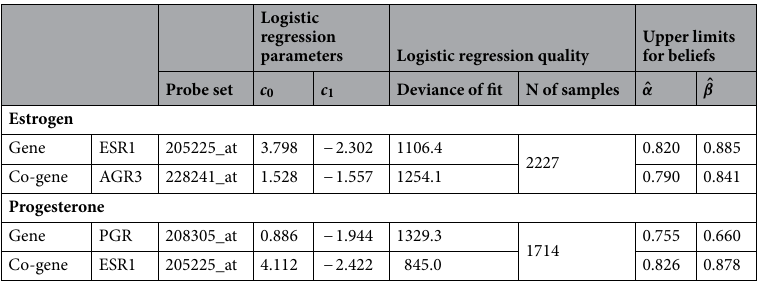
Table 1. Receptor genes, co-genes and parameters from logistic regression. Probe sets refer to the Affymetrix chip U133A + 2.0. For ‘deviance of fit’, see p.118 in McCullagh 81 . Note the double role of ESR1: It is the very receptor gene for ER but also serves as best co-gene for PGR, see our previous work 57 regarding the selection of ˆ β) co-genes. Upper limits for beliefs ( ˆ α , are explained in the next section (Eqs.